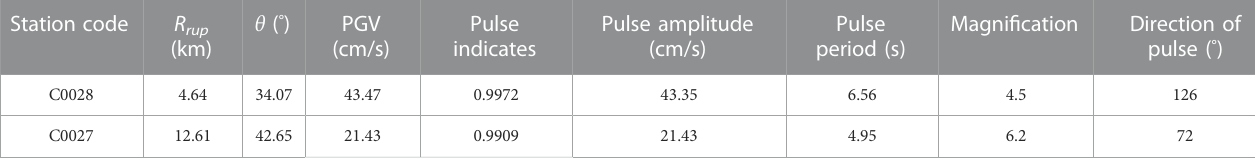
TABLE 5 Main parameters of typical pulse-like recordings for the M S 6.9 Menyuan earthquake. Station